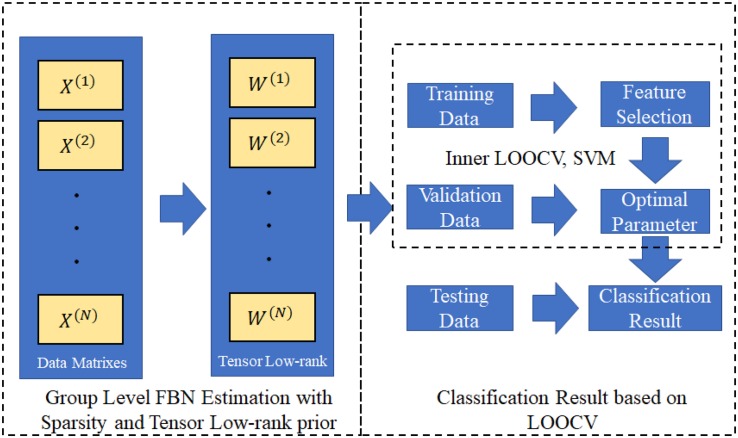
This flowchart shows the TLR/STLR implementation in group level FBN estimation and use of LOOCV for classification.